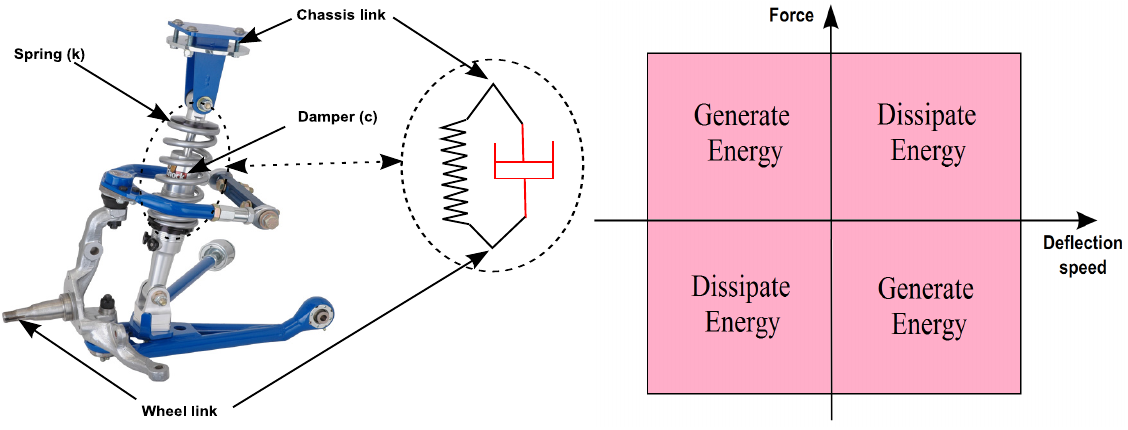
Figure 1. Suspension system ( left ) and Speed-Effort Rule ( right